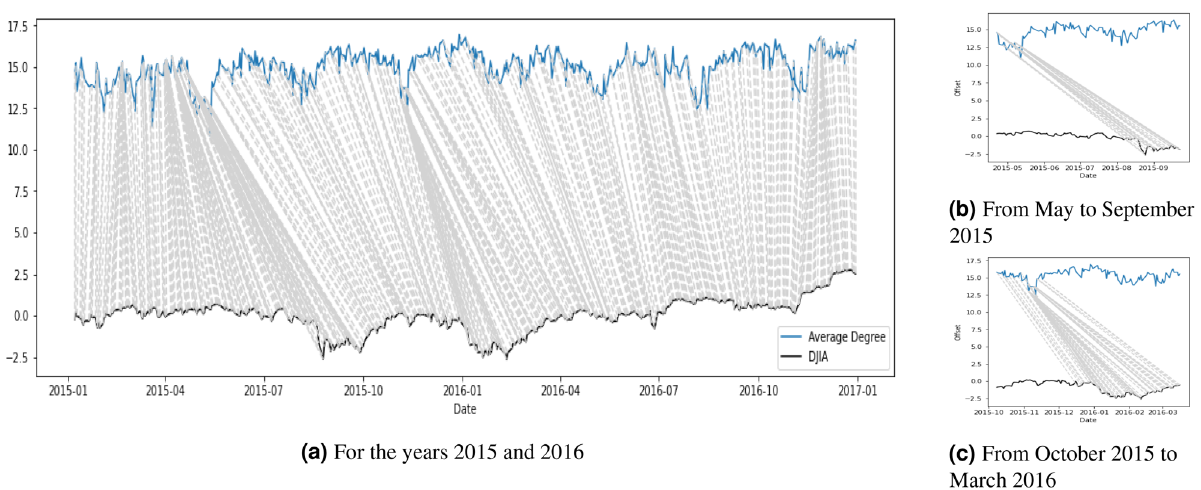
Figure 8. Dynamic time warping: point-by-point comparison between average degree and DJIA for the years 2015 and 2016, both series